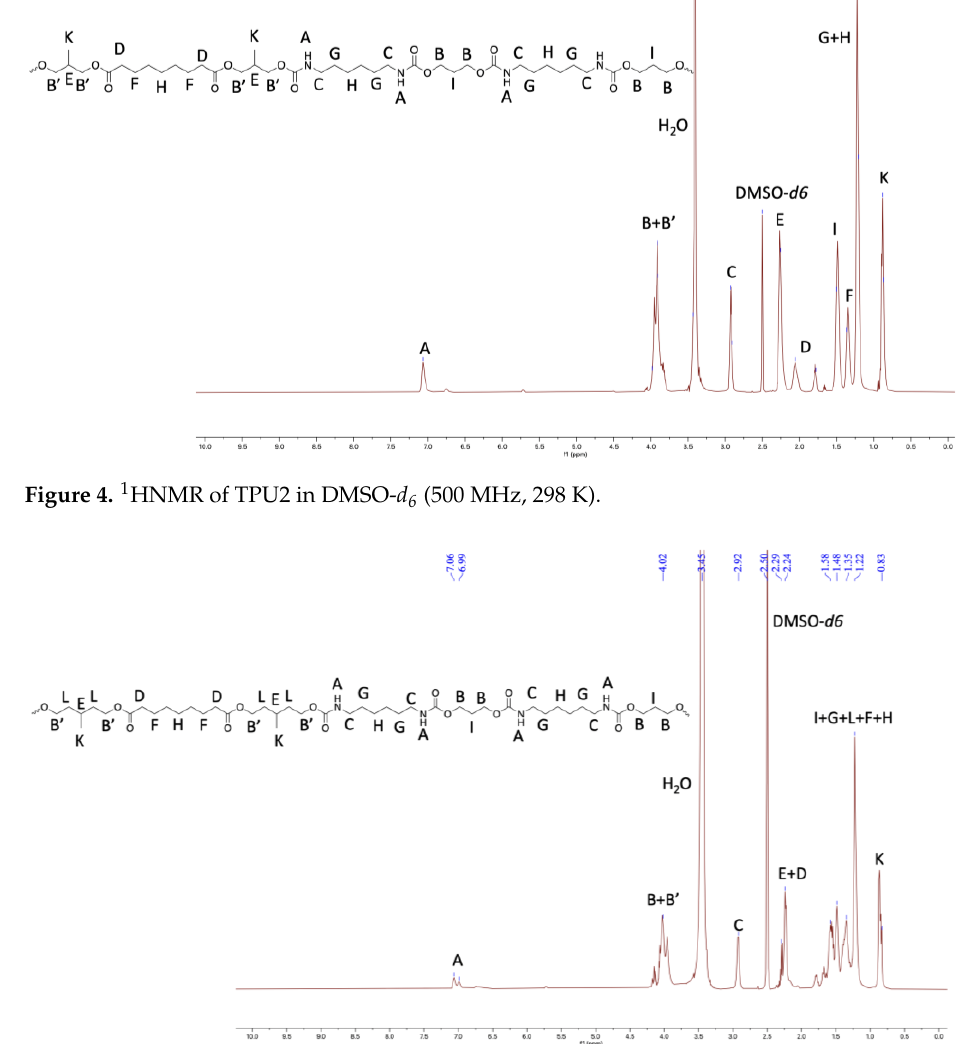
Figure 5. 1 HNMR of TPU3 in DMSO- d6 (500 MHz, 298 K).